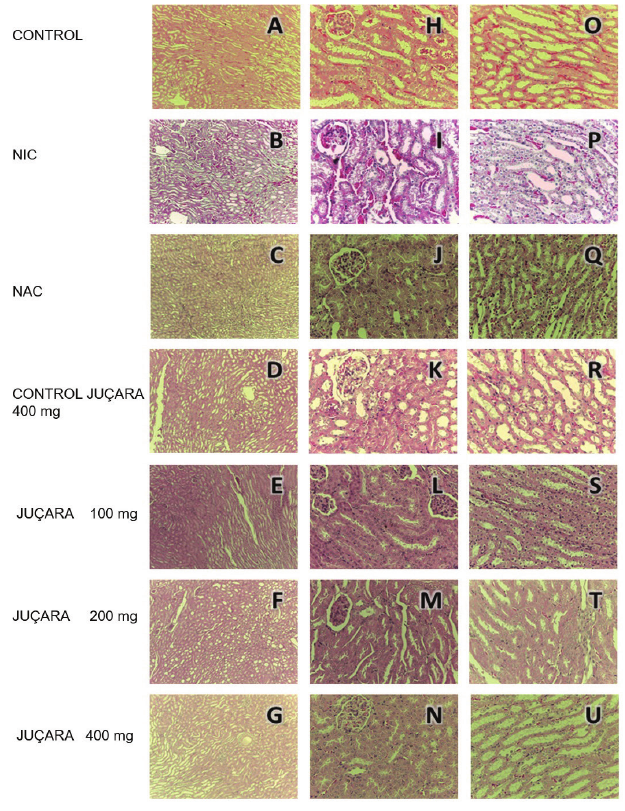
FIGURE 4 - Representative micrographs showing the renal histology of the mice after the induction of NIC. Groups: CN, negative control; NIC, contrast nephropathy; NAC, 100 mg/kg N-acetylcysteine; EE100, 100 mg/kg E. edulis + NIC; EE200, 200 mg/kg E. edulis + NIC; EE400, 400 mg/kg E. edulis + NIC; and EE400WT, control 400 mg/kg E. edulis . Images A to G: cortex-medulla section (100x), demonstrating changes in the typical renal architecture; Images H to N: cortical region (400x); and images O to U: medulla region (400x) showing tubulointerstitial